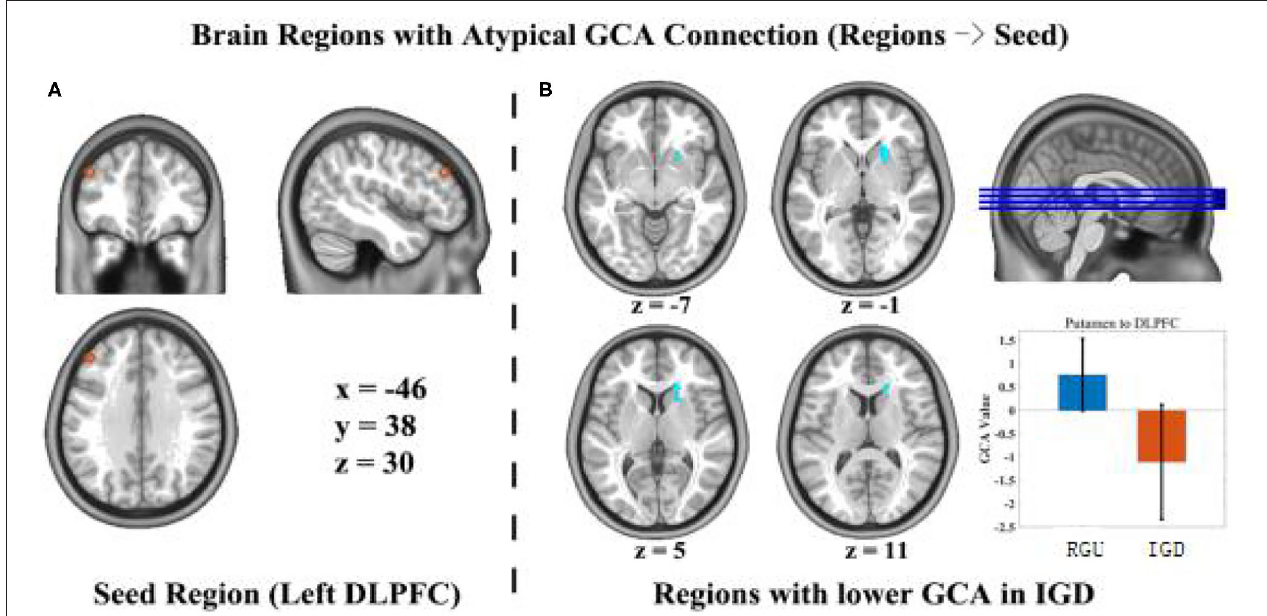
FIGURE 1 | Differences in GCA results between the IGD group and RGU group during resting state. p < 0.05 (AlphaSim correction). Voxel size = 3 × 3 × 3 mm 3 , the orange circle is the seed point of the DLPFC left-brain position (A) . The blue circle represents an efficient connection with the seed point to abnormal brain areas (B) .